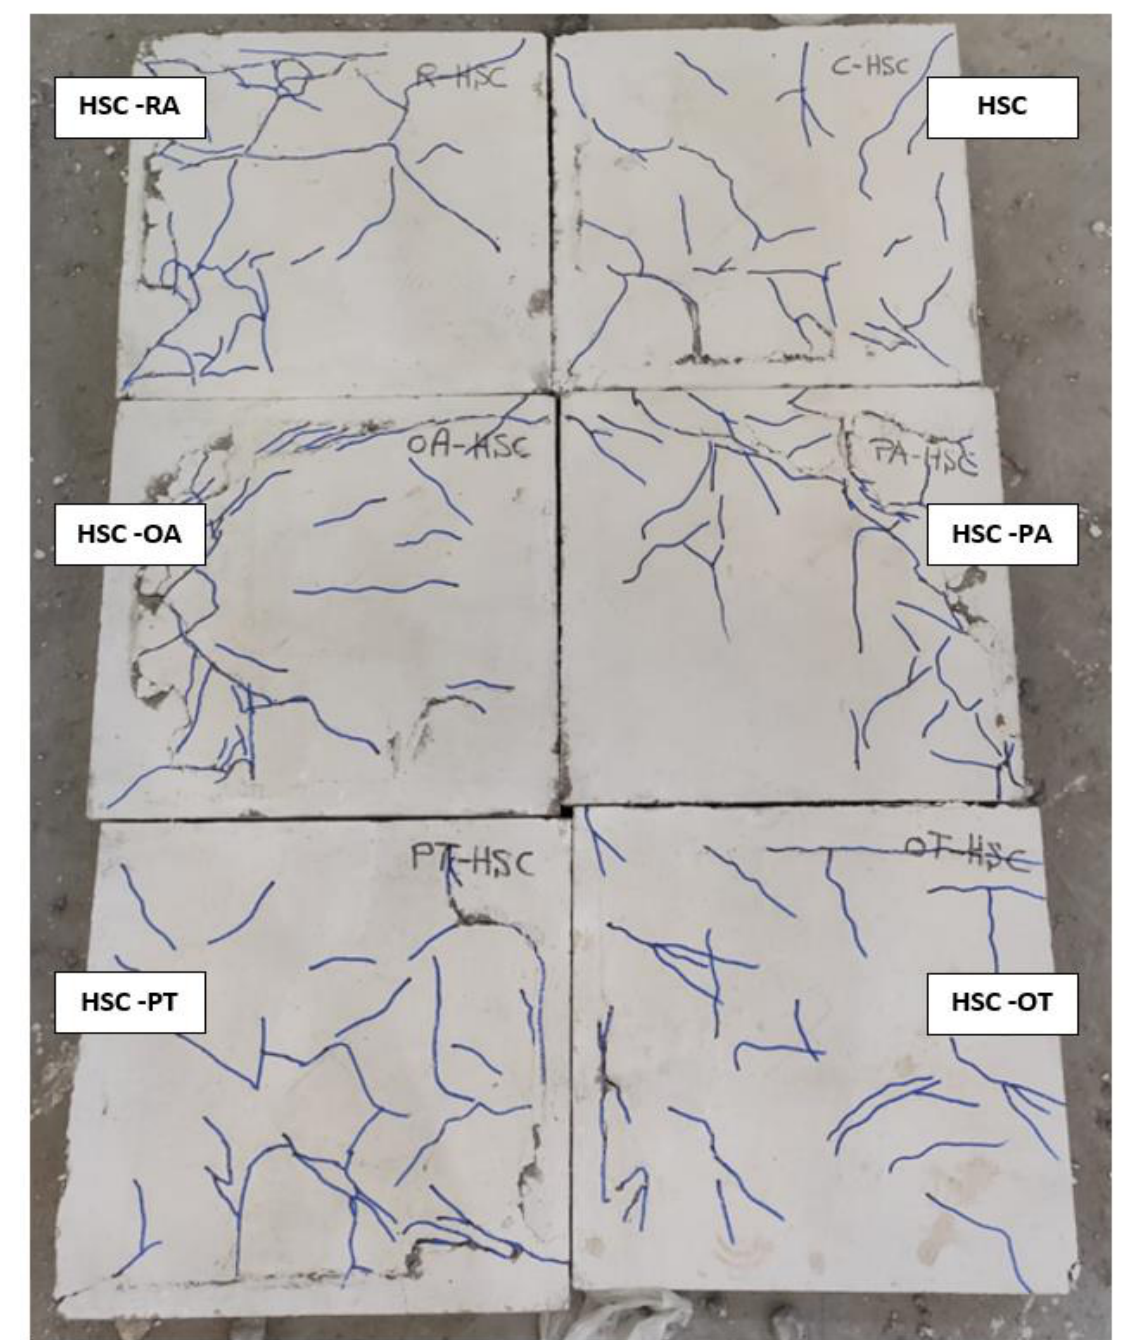
Figure 8. HSC specimens cracks.